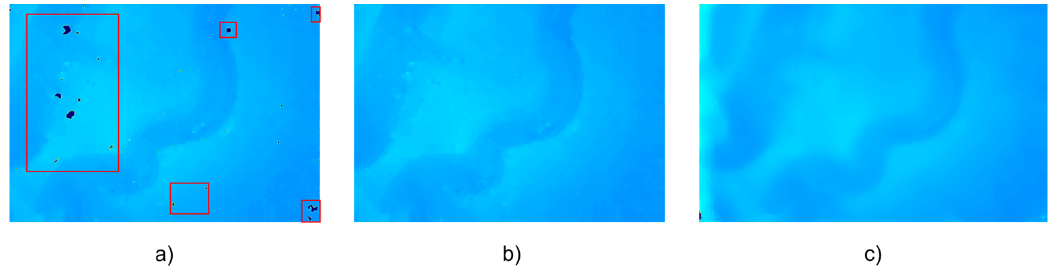
Figure 4. ( a ) Disparity map by SGBM. ( b ) Hole-filled Disparity map by SGBM. ( c ) Disparity map by StereoNet.